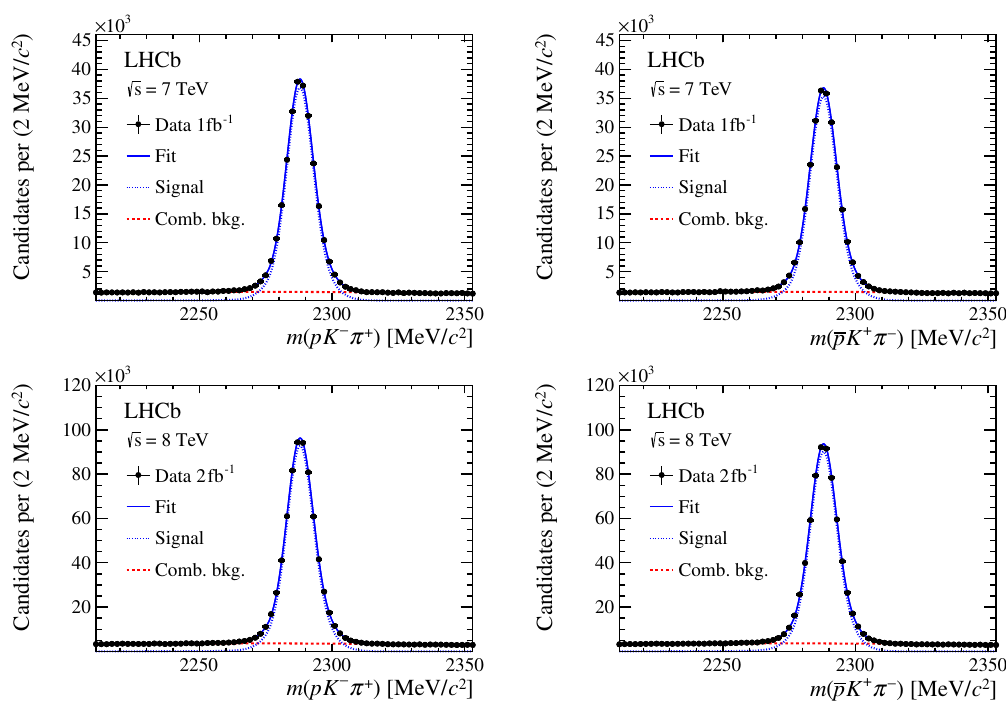
Figure 3 . Distributions of the pK (cid:0) (cid:25) + invariant mass for (left) (cid:3) + for the (top) p s = 7 TeV and (bottom) p s = 8 TeV data set. Fits to the distributions, as described in the text, are shown as